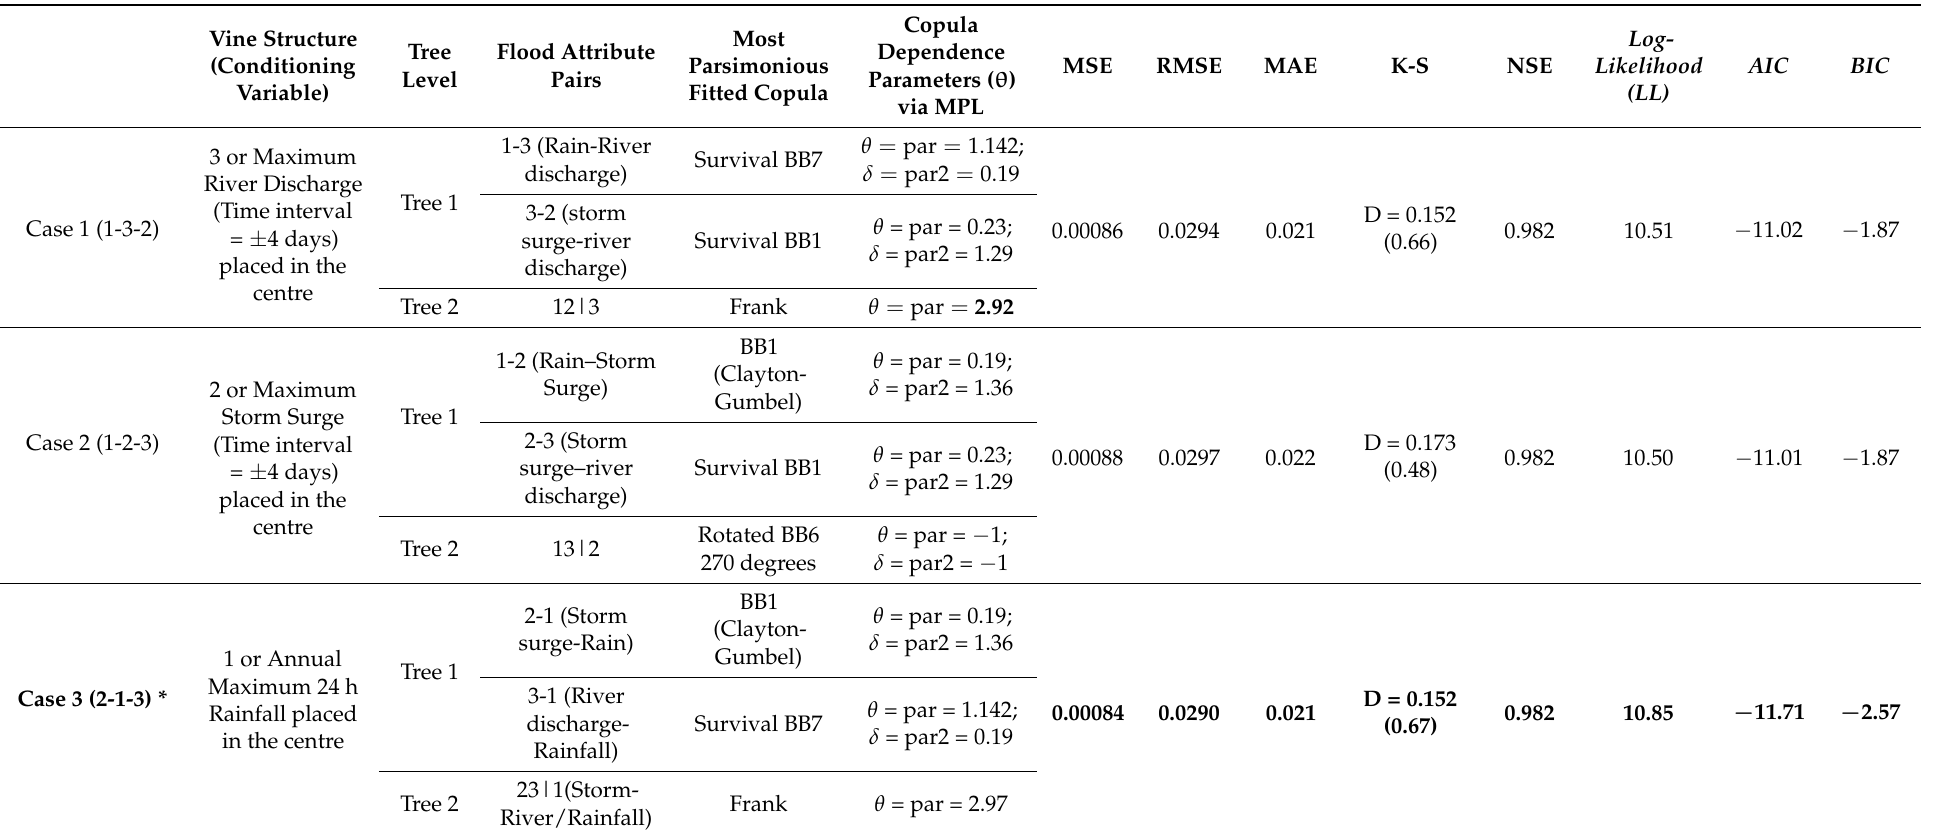
Table 5. Summary statistics of the fitted D-vine structure under parametric distribution settings (via parametric copulas with parametric marginal